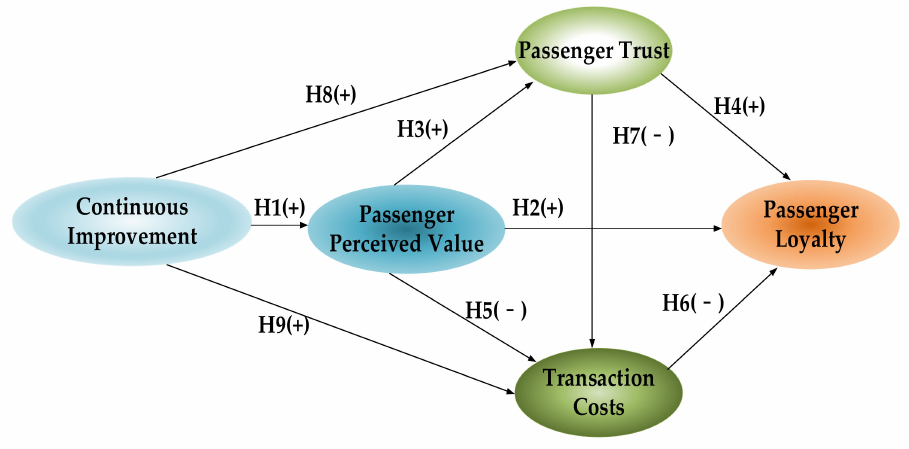
Figure 5. Alternative Model 2.